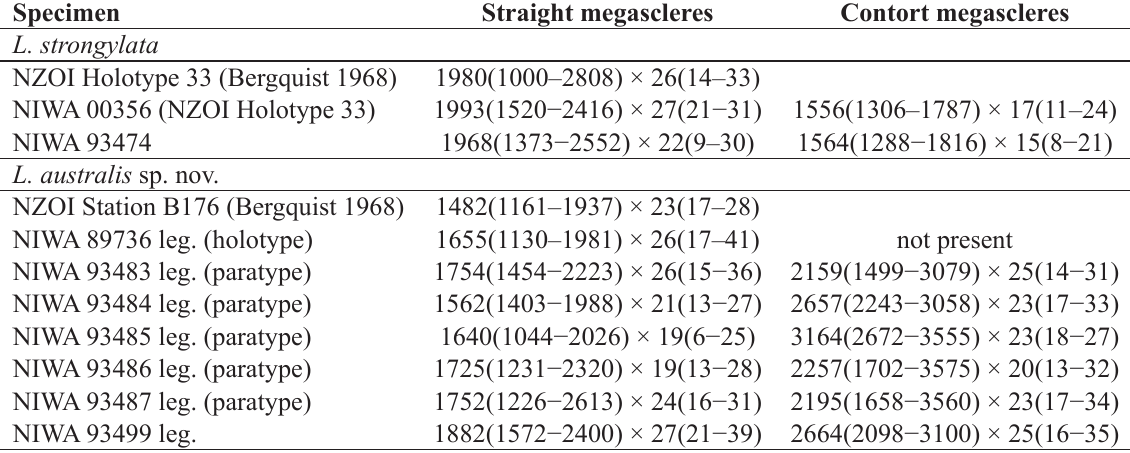
Table 1. Megascleres and dimensions (µm) of Lamellomorpha strongylata Bergquist, 1968 and L. australis Kelly & Cárdenas sp. nov., given as length [mean (min.–max.)] × width [mean (min.– max.)], n = 10–17 unless stated